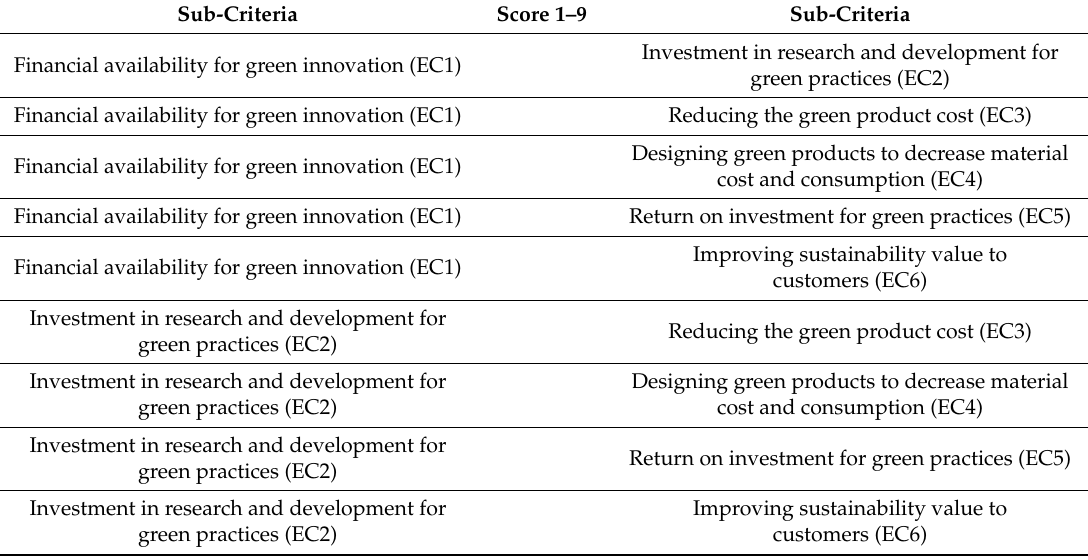
Table A2. Please rate the importance of sub-criteria (EC1–EC6) against each sub-criteria (EC1–EC6) relating to the economic (EC)